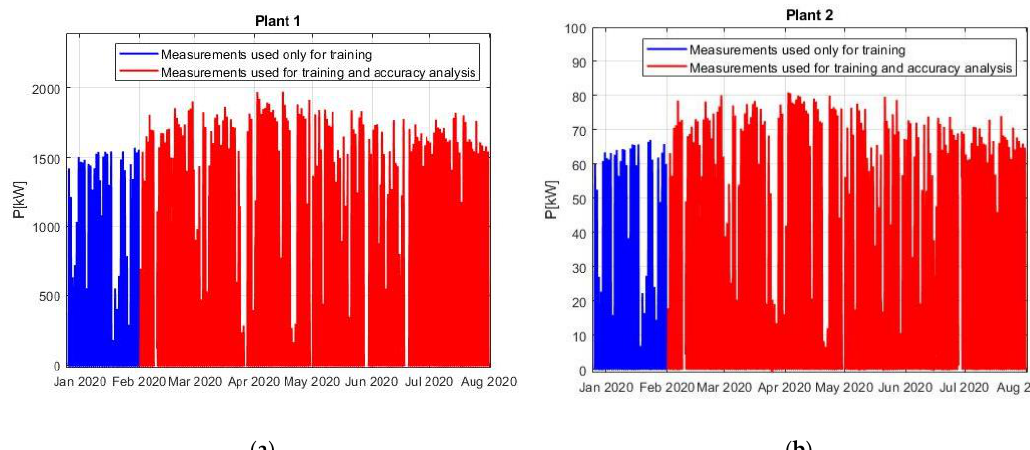
Figure 5. Power production used in the simulations. ( a ) Plant 1; ( b ) Plant 2.